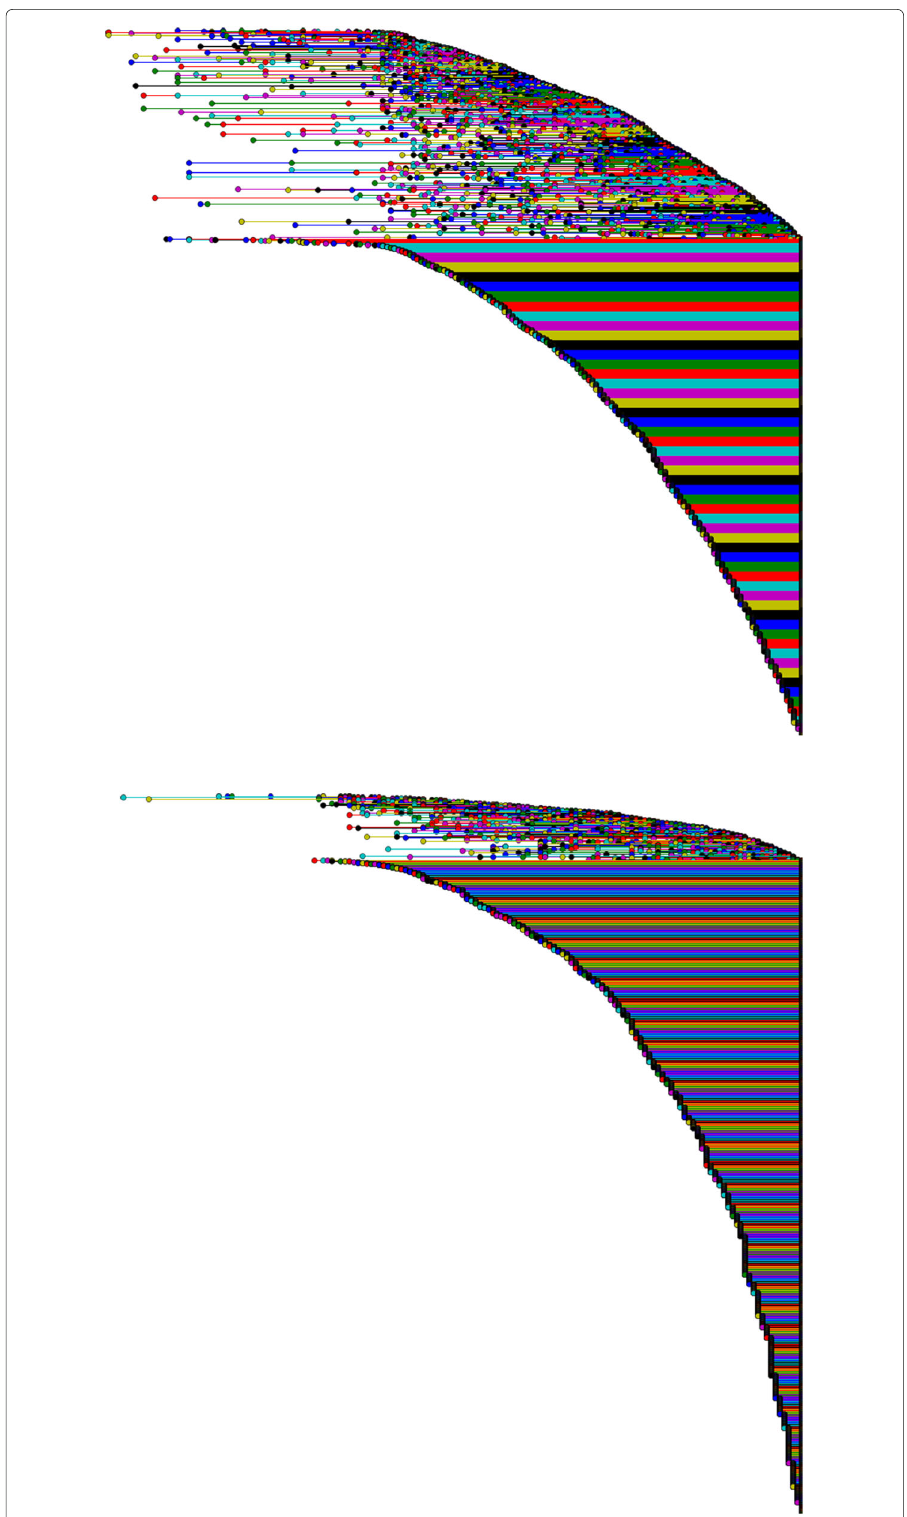
Fig. 7 Barcodes for H 1 (top) and H 2 (bottom), ordered for death time. The left and right endpoints of each segment represent the first and last step in the filtration where the hole